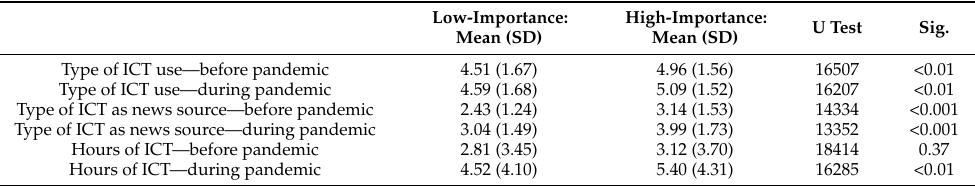
Figure 1. Response distributions for the importance of the social connectedness variable. Table 2. Comparison of information and communications technology (ICT) use variables between low- and high-importance groups.